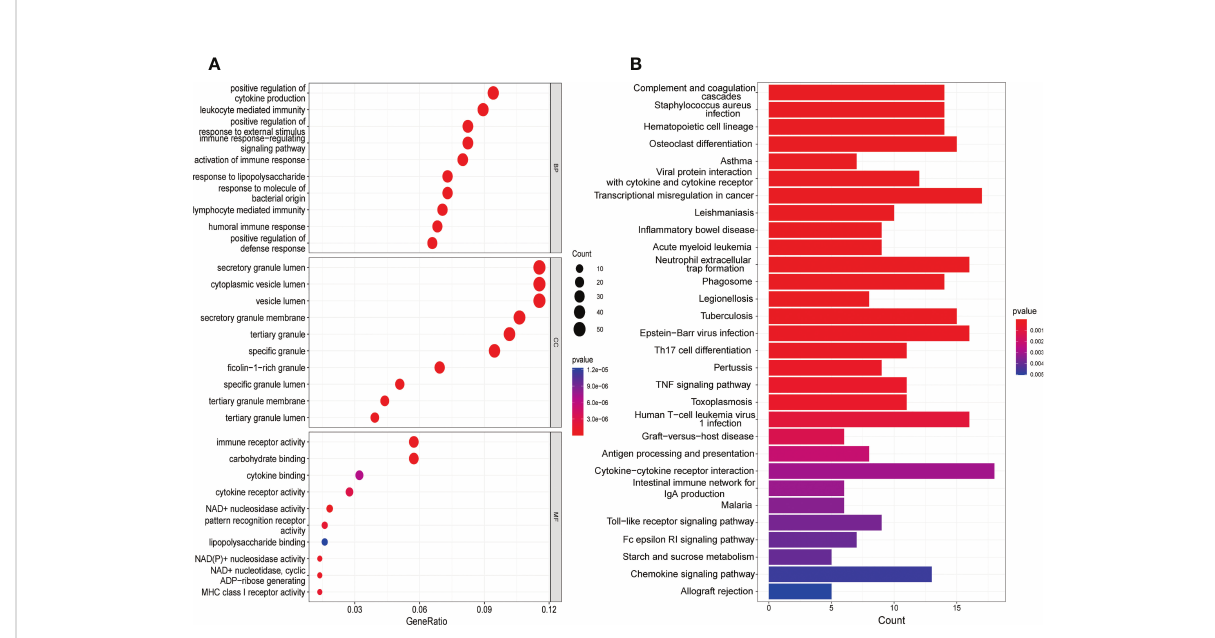
FIGURE 3 Functional enrichment analysis of DEGs. (A) The top 10 functional enrichment in BP, CC, and MF analysis, respectively. (B) The KEGG analysis of